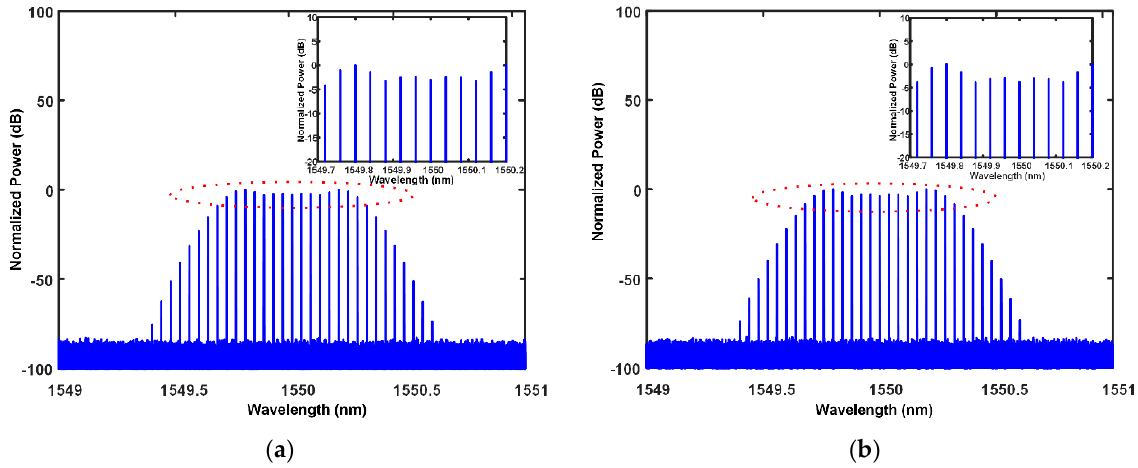
Figure 5. Simulated spectra of the generated OFCs. ( a ) The MZM is biased at 0.6 π and with a modulation index of 0.4 π . ( b ) The MZM is biased at 0.5 π (i.e., its quadrature point) and with a modulation index of 0.5 π .